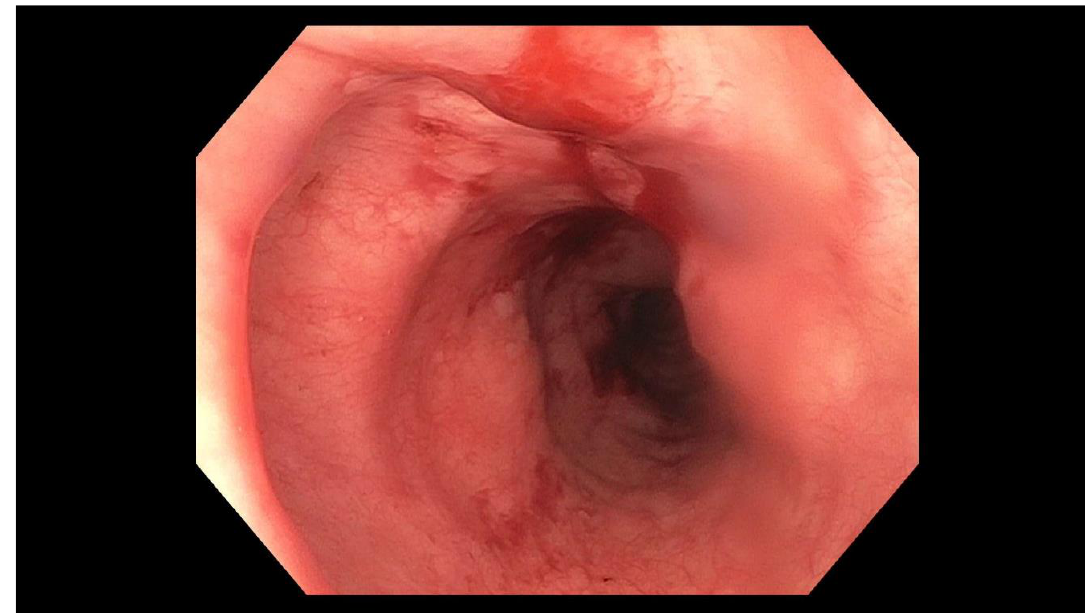
Figure 2. Mucosal damage in the middle third of the esophagus.